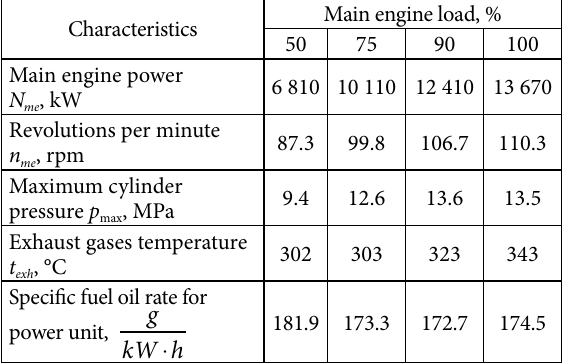
Table 4. Outcome of the main engine trial